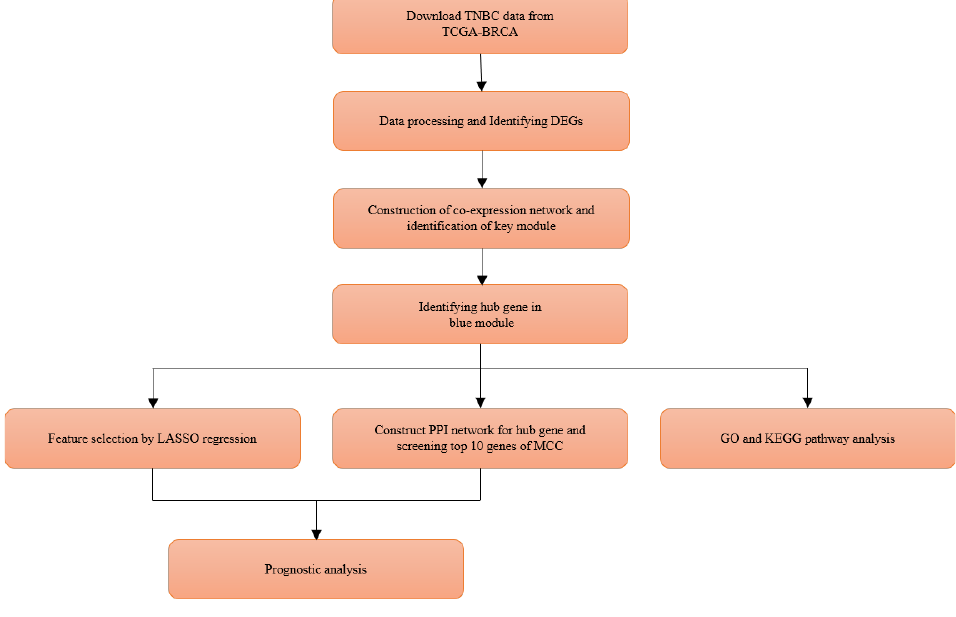
Figure 1. Flowchart of this study.